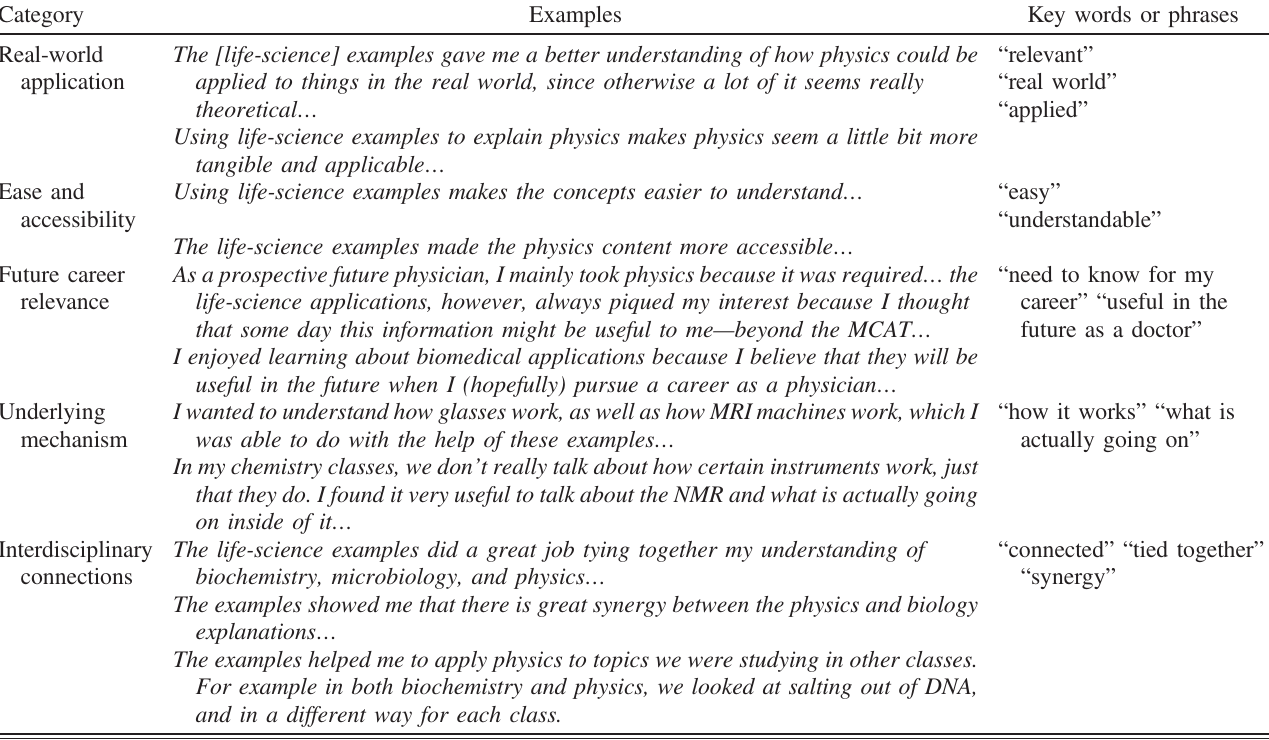
TABLE IV. Five categories appeared repeatedly in student responses to the open-ended prompt about the source of their interest in the life-science contexts. Example student statements and keywords are provided to better articulate the category meanings. Category